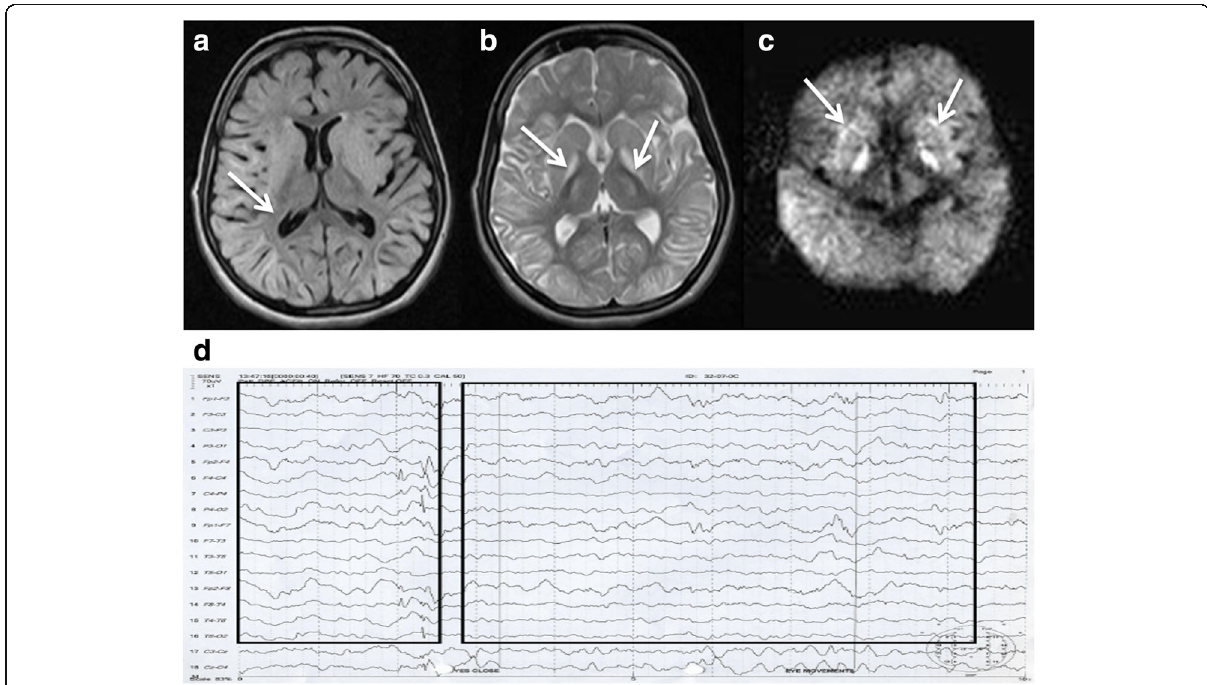
Fig. 1 Clinical features of individuals homozygous for L2HGDH c.178G > A. Patient VI:4 at 16 years of age, showed diffuse T2 hyperintense signals abnormality in the subcortical white matter ( a ), bilateral symmetrical T2 hyperintense signals in bilateral basal ganglia ( b ) and cerebellar atrophy ( c ) and epileptiform changes in EEG ( d